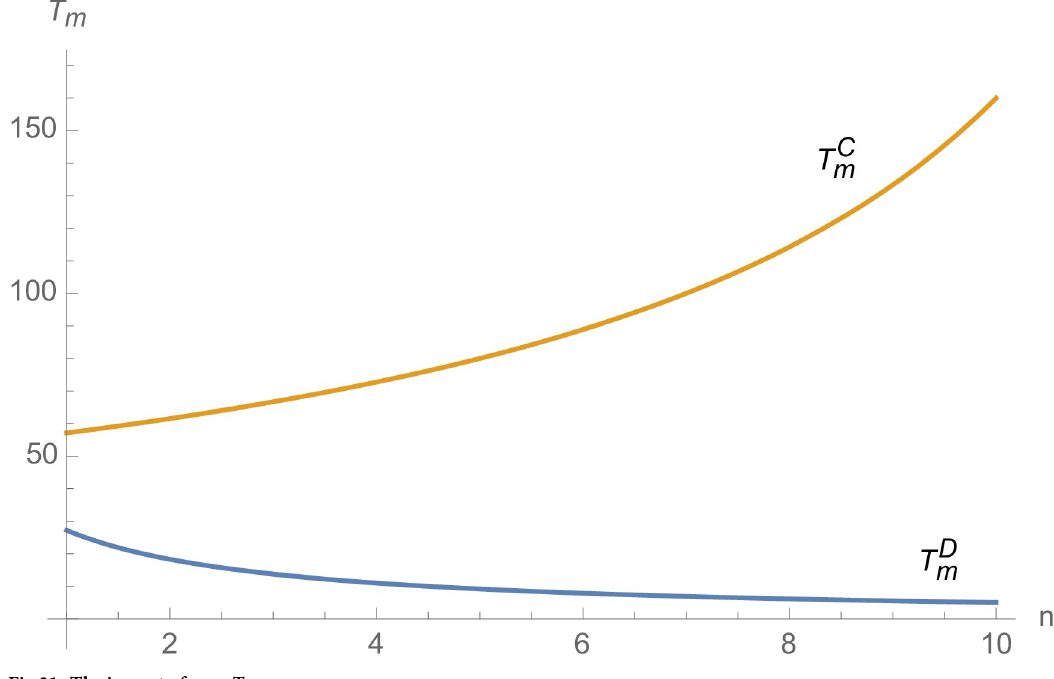
Fig 31. The impact of n on T m .